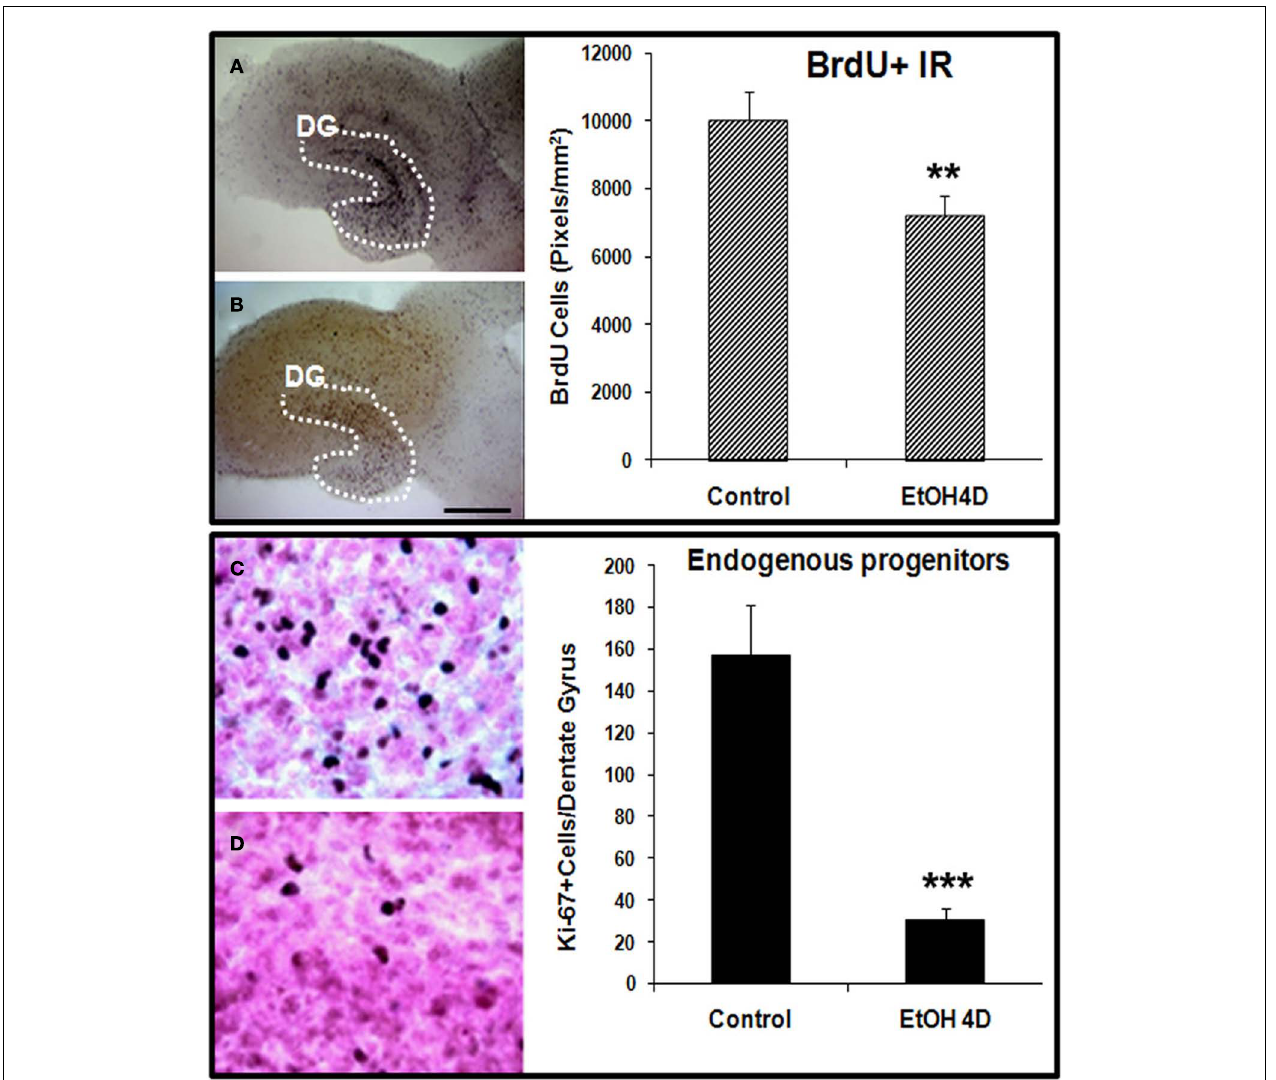
HEC slices at 10 DIV were treated with ethanol (100mM) for 96h and then stained with Ki67, a marker for endogenous progenitors. Ki67 positive cells in DG of the hippocampus were quantified as described in Methods. Shown in bar graph are mean ± SEM of Ki67 + cells counted in each dentate gyrus. Ethanol treatment for 4days significantly reduced number of endogenous progenitors labeled by Ki67. ANOVA following Fisher post hoc : *** p < 0.001 compared with control, n = 6.The representative photographs of Ki67 + IR were shown in control [ (C) , 40 × ] and ethanol group [ (D) , 40 ×